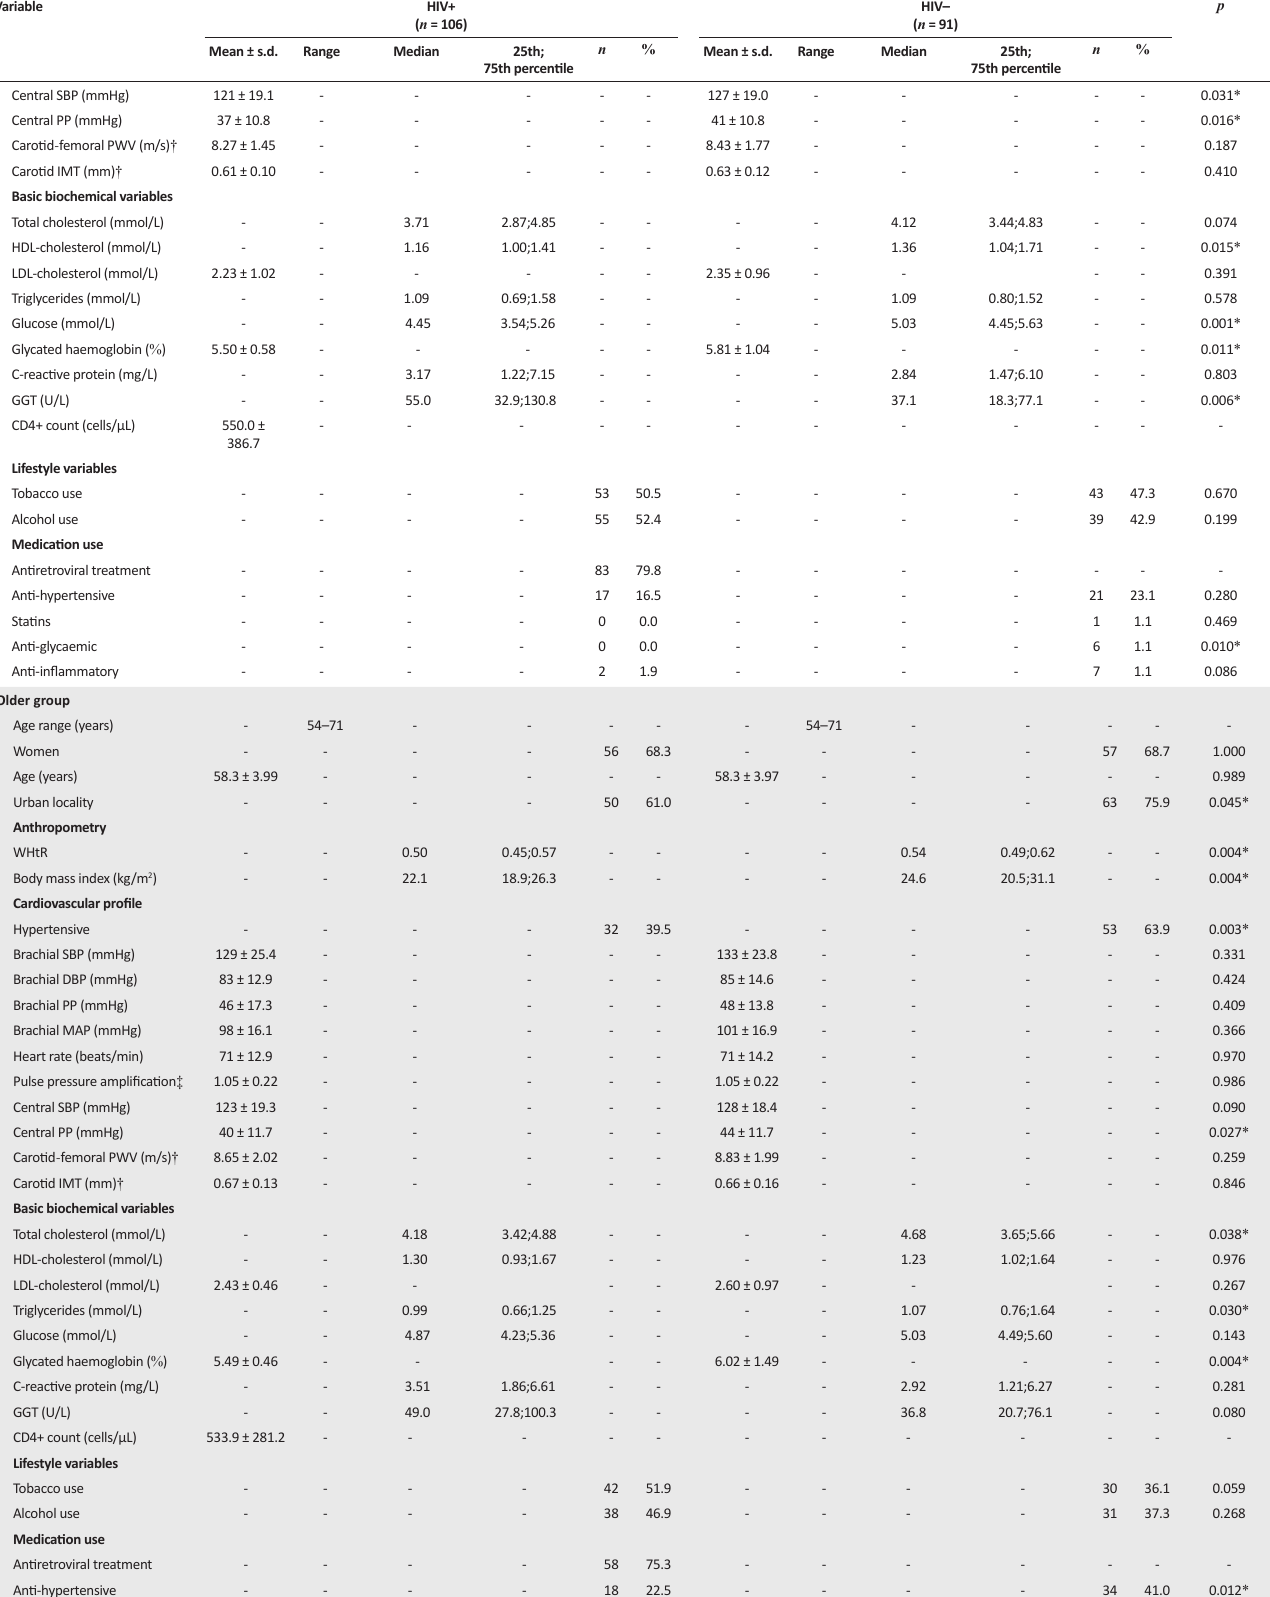
TABLE 1-A1 (Continues...): Characteristics of PLWH and without HIV, stratified by age tertile groups. Variable